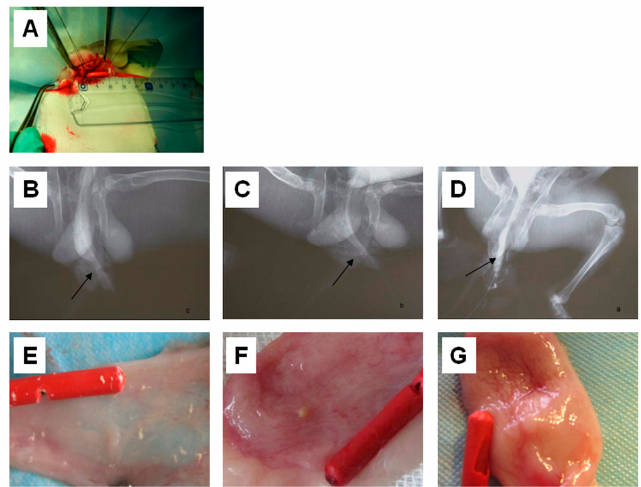
Figure 5. Implantation of electrospun PLLA/PEG scaffolds and human amniotic mesenchymal cells (hAMSCs) in urethral defects of rabbits. ( A ) A urethral mucosa defect of about 2 × 1.5 cm was formed in a rabbit; ( B – D ) Retrograde urethrograms of the rabbits that were subjected to a mock operation ( B ), implanted with PLLA/PEG scaffold ( C ); and hAMSCs–PLLA/PEG construct ( D ); respectively; ( E – G ) Gross observation of mucosa healing and calculus formation in the rabbits that were subjected to a mock operation ( E ); implanted with PLLA/PEG scaffold ( F ); and hAMSCs–PLLA/PEG construct ( G );